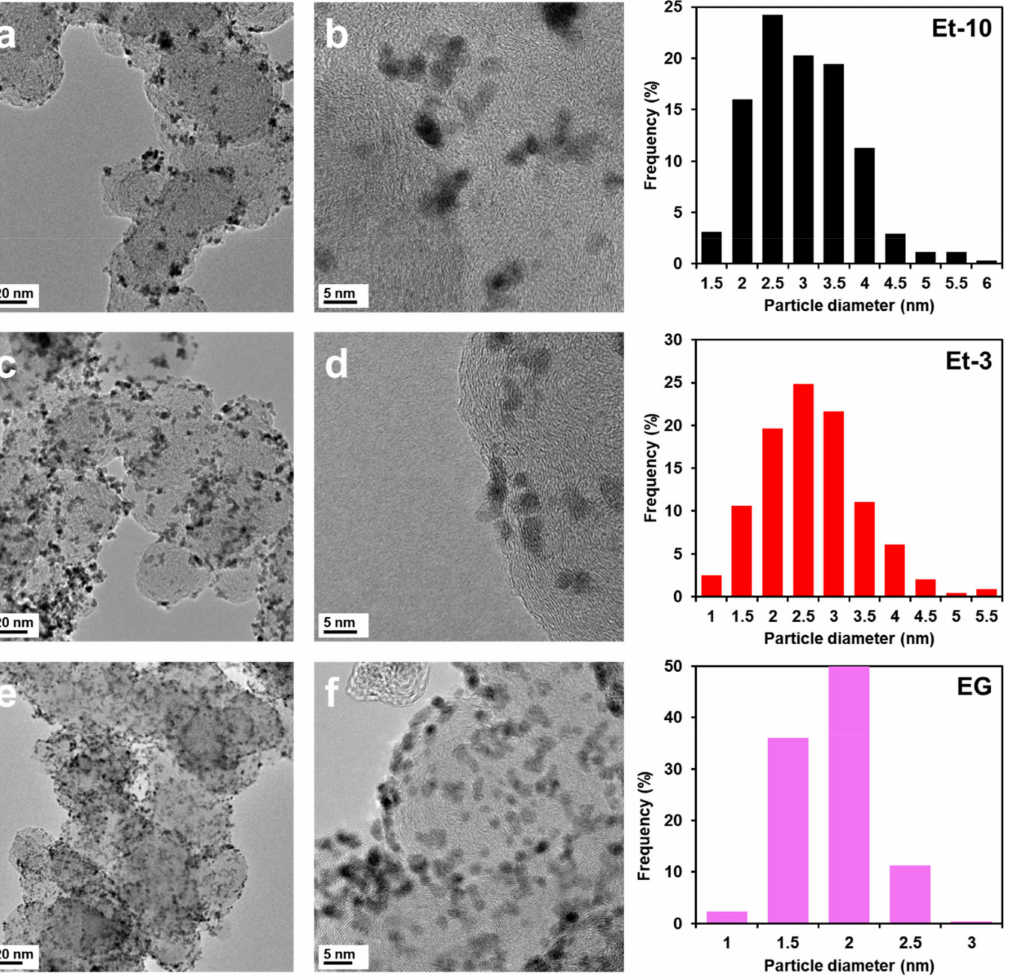
Figure 2. TEM micrographs of the Et-10 ( a , b ), Et-3 ( c , d ), EG ( e , f ) samples and histograms of the particles’ distribution in the